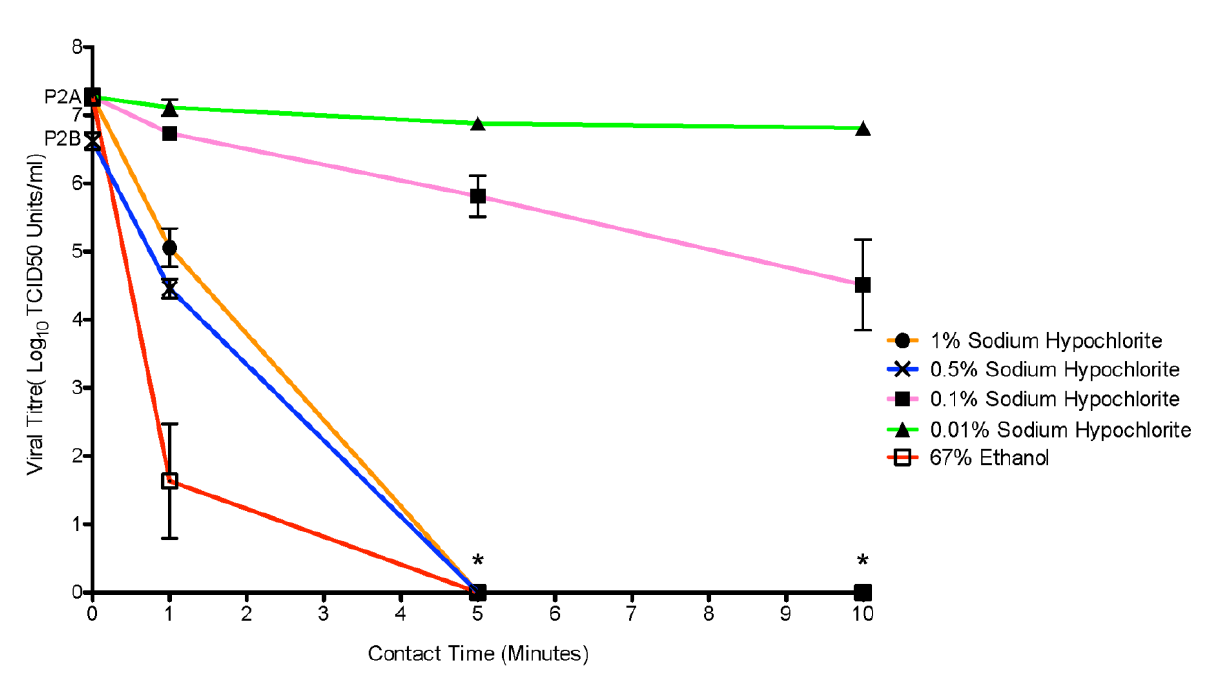
Figure 2. Efficacy of the standard disinfectants sodium hypochlorite and ethanol against EBOV Makona (EBOV/Mak) in an organic soil load . Various concentrations of v/v sodium hypochlorite (0.01%, 0.5%, 0.1%, 1%) and 67% ethanol were tested over contact times of 1 minute, 5 minutes and 10 minutes. Recovered viral titres were measured per/mL by the TCID 50 assay. The asterisks ( * ) denote where a limit of detection for the TCID 50 assay was overcome for 0.5% and 1% sodium hypochlorite samples. In order to confirm complete kill at the 10 0 dilutions the samples were pooled in three groups of three (n = 9) and used to infect T150 flasks. Complete kill of EBOV/Mak with 0.5% and 1% sodium hypochlorite treatment was confirmed by this method for the 5 and 10 minute contact times. The error bars represent the standard error of the mean. For the tested disinfectants three biological replicates of 3 technical repetitions were performed at every time point (n =